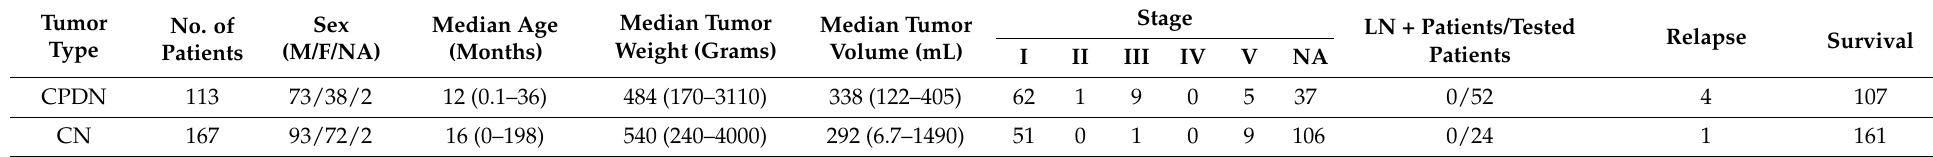
Table 1. Clinical characteristics and outcome of cystic partially differentiated nephroblastoma (CPDN) and cystic nephroma